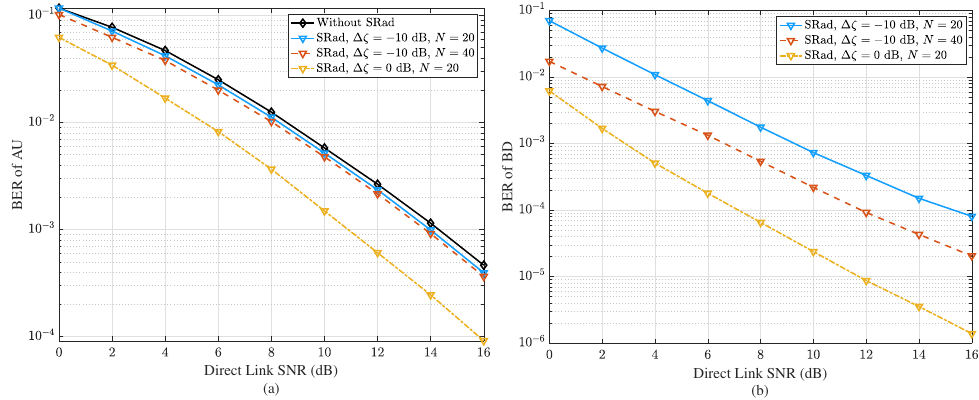
Figure 6. SRad performance in terms of ( a ) BER of AU with QPSK modulation. ( b ) BER of BD with BPSK modulation. ∆ ζ represents the ratio of SNR between the backscattering link and direct link, and the duration of one BD symbol is equal to N times of AU